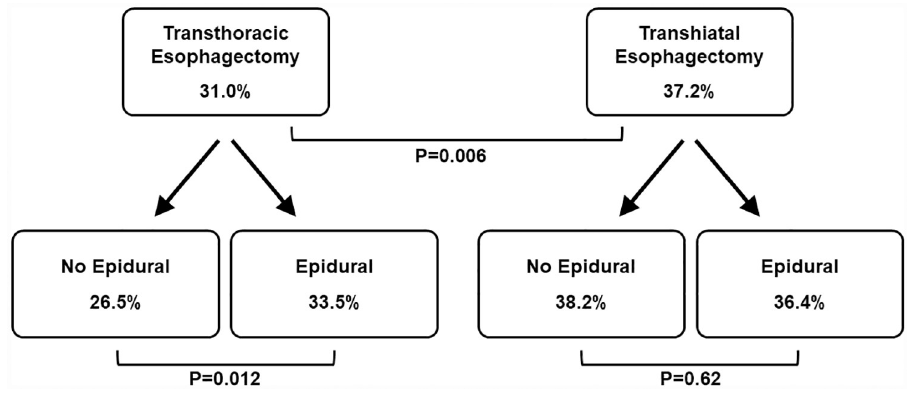
Fig 3. Five-year survival by surgical approach and, within each surgical group, by epidural status. P values are from Z-tests comparing Kaplan-Meier estimates of 5-year survival